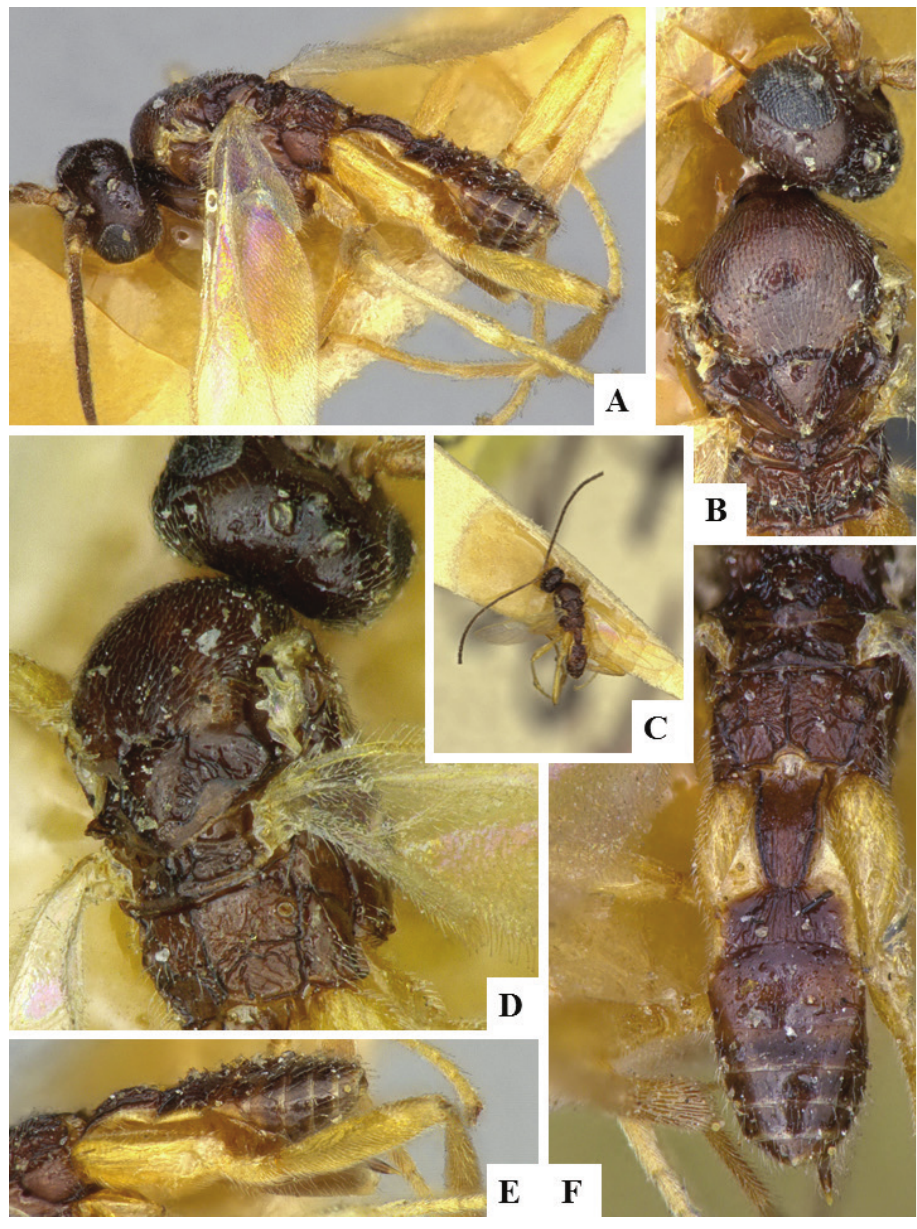
Figure 25. Glyptapanteles pallipes. A Habitus, lateral B Head and mesosoma, dorsal C Habitus, dorsal D Head and mesosoma, dorso-laterally E Metasoma, lateral F Metasoma,